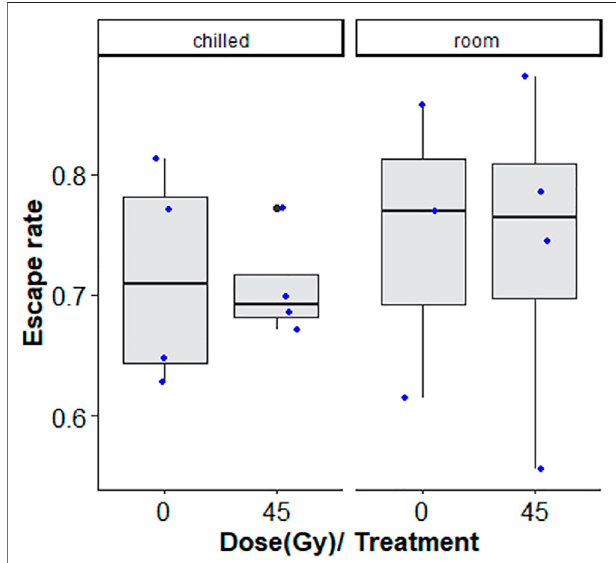
FIGURE 4 | Flight ability of chilled versus non-chilled, sterile Aedes albopictus maleadults irradiated at45 Gyornotirradiated Theboxplot shows the median, and upper and lower quartiles. The dots indicate the values obtained for each repetition.